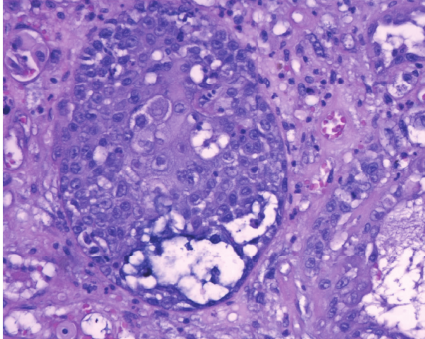
Figure 2: Mucoepidermoid carcinoma: glandular-like structure composed of a mixture of squamous and clear cells containing mucin (hematoxylin and eosin, 40x).